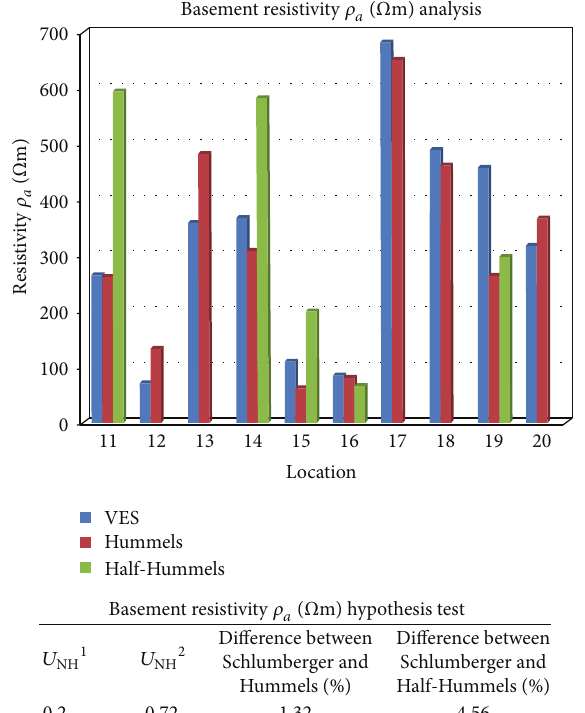
Figure 26: Bar chart and statistical test of hypothesis table for the different array methods comparing basement resistivity for locations on amphibolite.